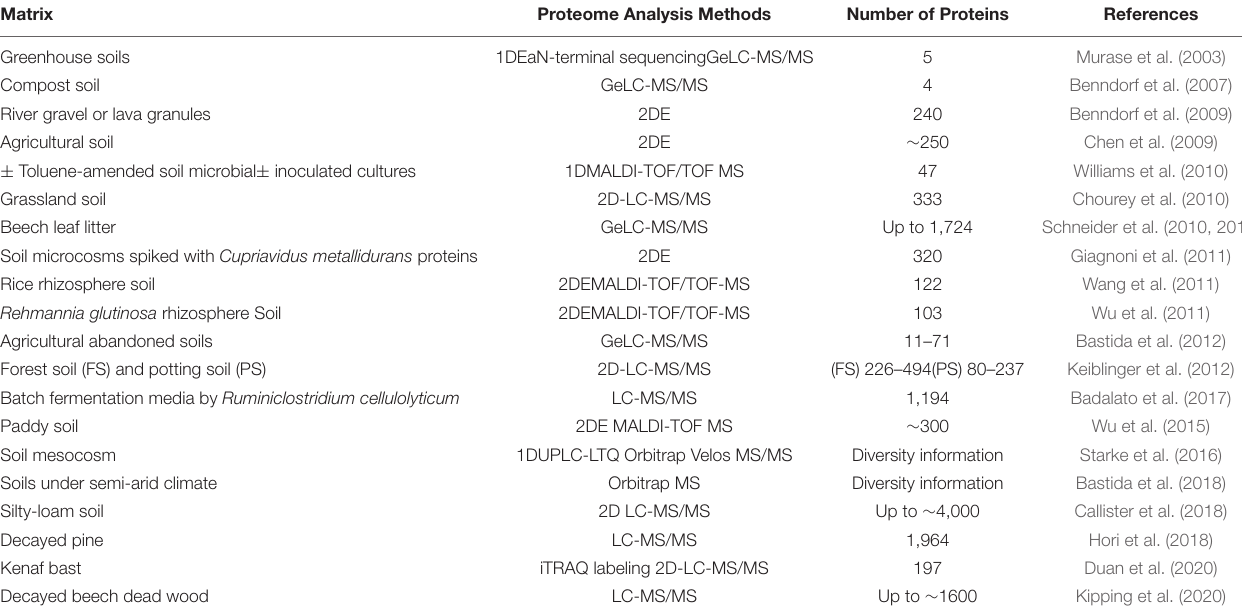
TABLE 6 | Selected studies performed on biologically-similar to retting systems reporting detection or identification of proteins using different proteo- and metaproteomic